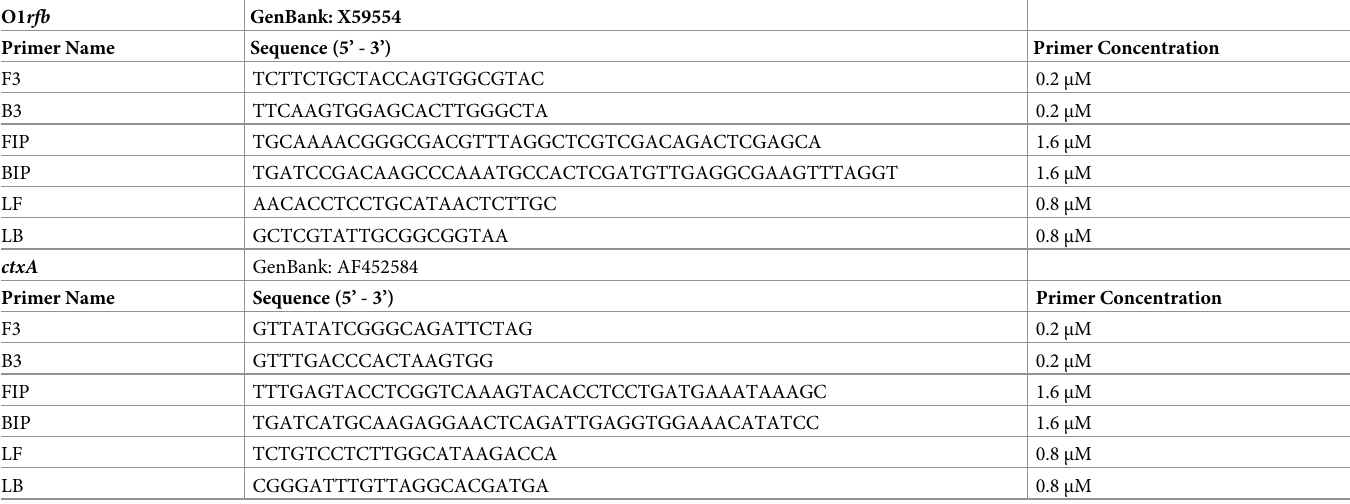
Table 1. List of cholera RLDT primers used in this